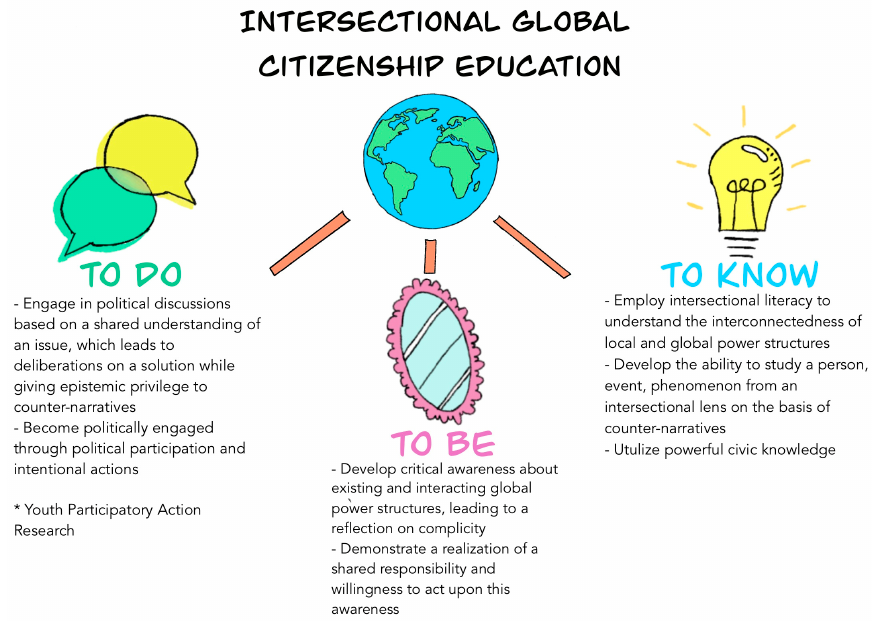
Figure 2. Visual representation of an intersectional approach to Global Citizenship